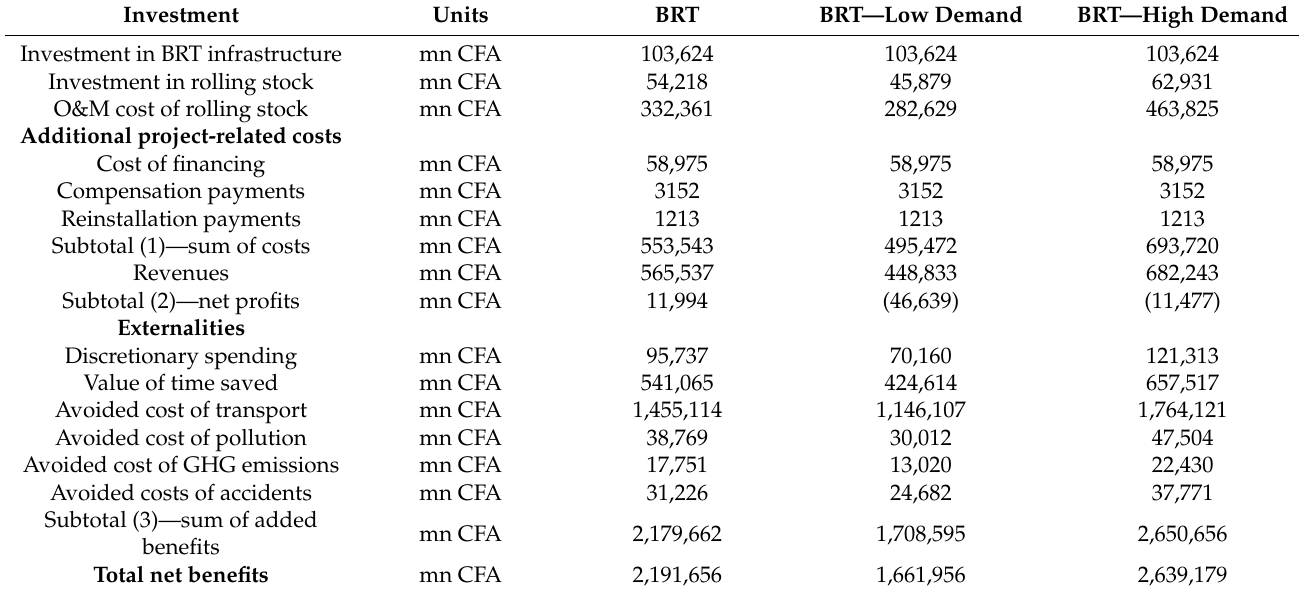
Table 7. Integrated cost–benefit analysis for BRT in Dakar